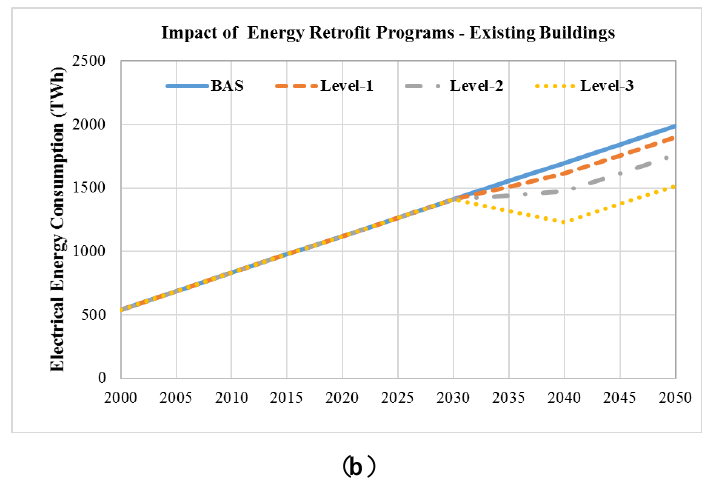
Figure 21. Impact on load profiles for electrical energy consumption due to implementation of energy retrofit programs for the entire existing building stock when the programs start during ( a ) 2020 and ( b ) 2030.